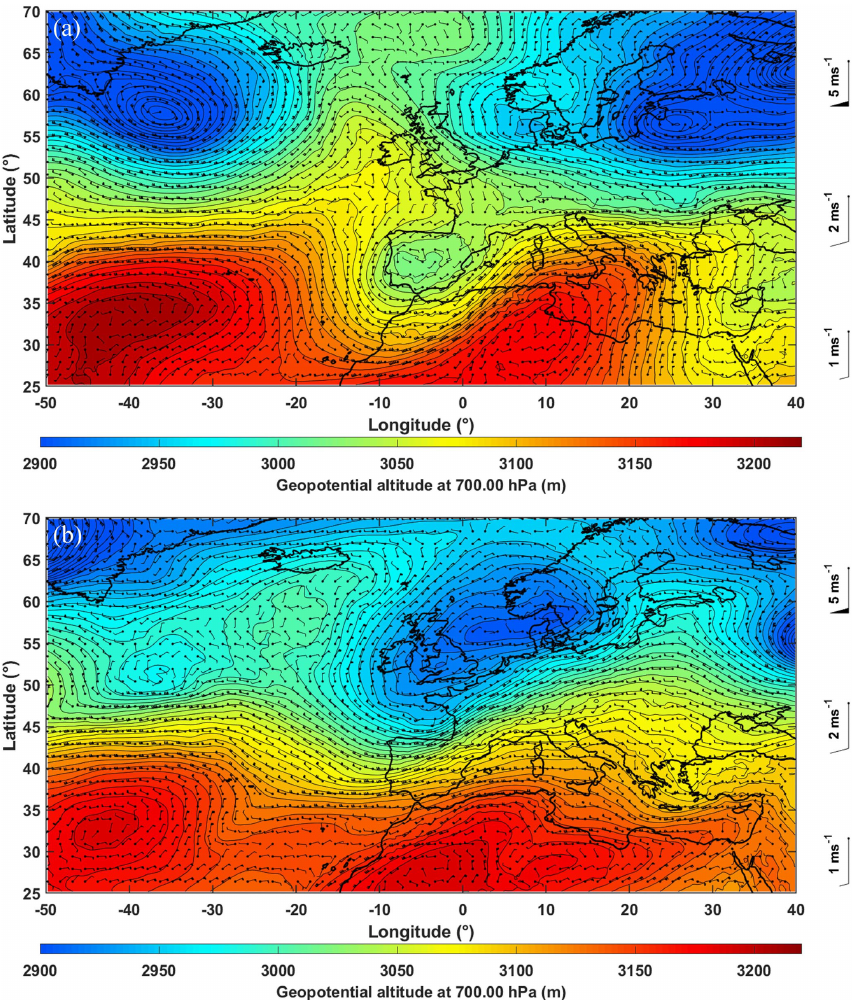
Figure 9. Geopotential altitude from the ERA5 reanalyses given for the pressure levels of 700hPa at 12:00UTC on (a) 24 and (b) 28 June 2014. The wind field is also shown in each panel. The horizontal resolution is 0.30 ◦ .